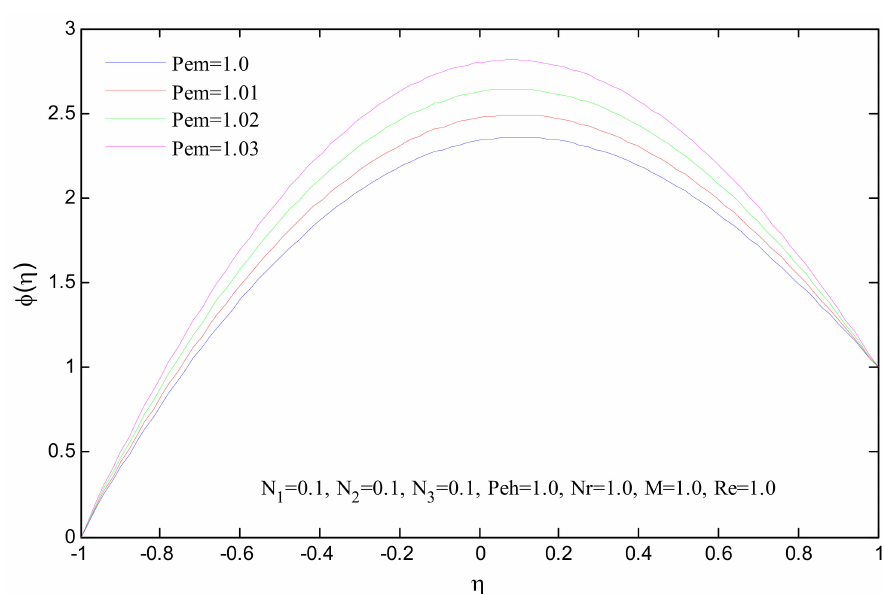
Figure 13. Effect of P em on mass concentration